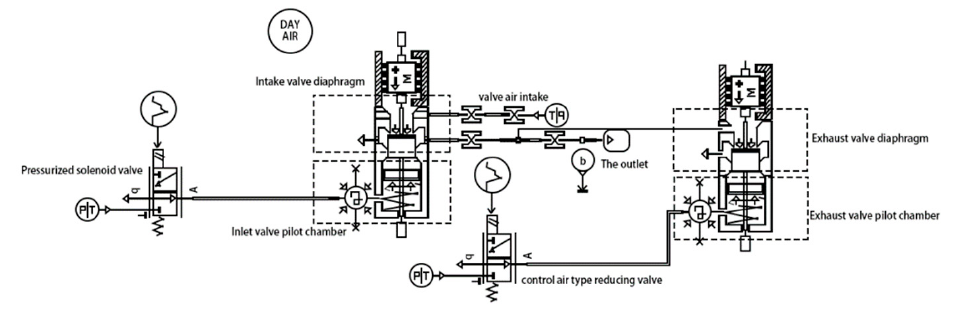
Figure 3. The structure diagram of ABS solenoid valve. ( T is the torque; P is the pressure; A is the trachea; b is the outlet; left M is the intake cavity; right M is the exhaust cavity). Table 3. ABS operating characteristics.